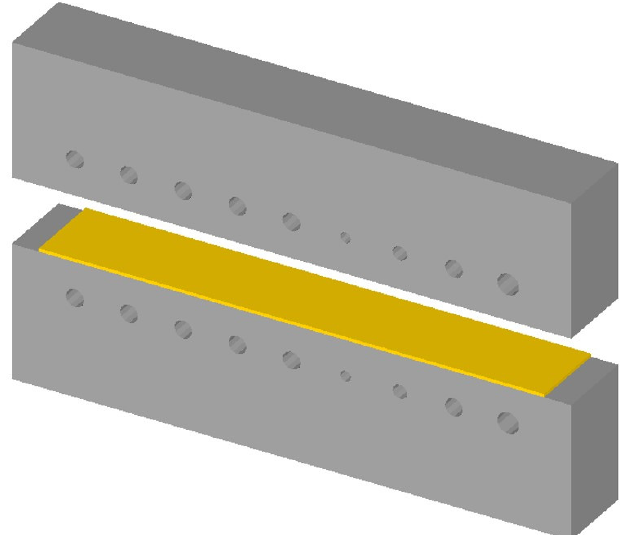
Figure 7. Finite-element model of hot stamping. Table 3. Thermal physical property of BR1500HS.